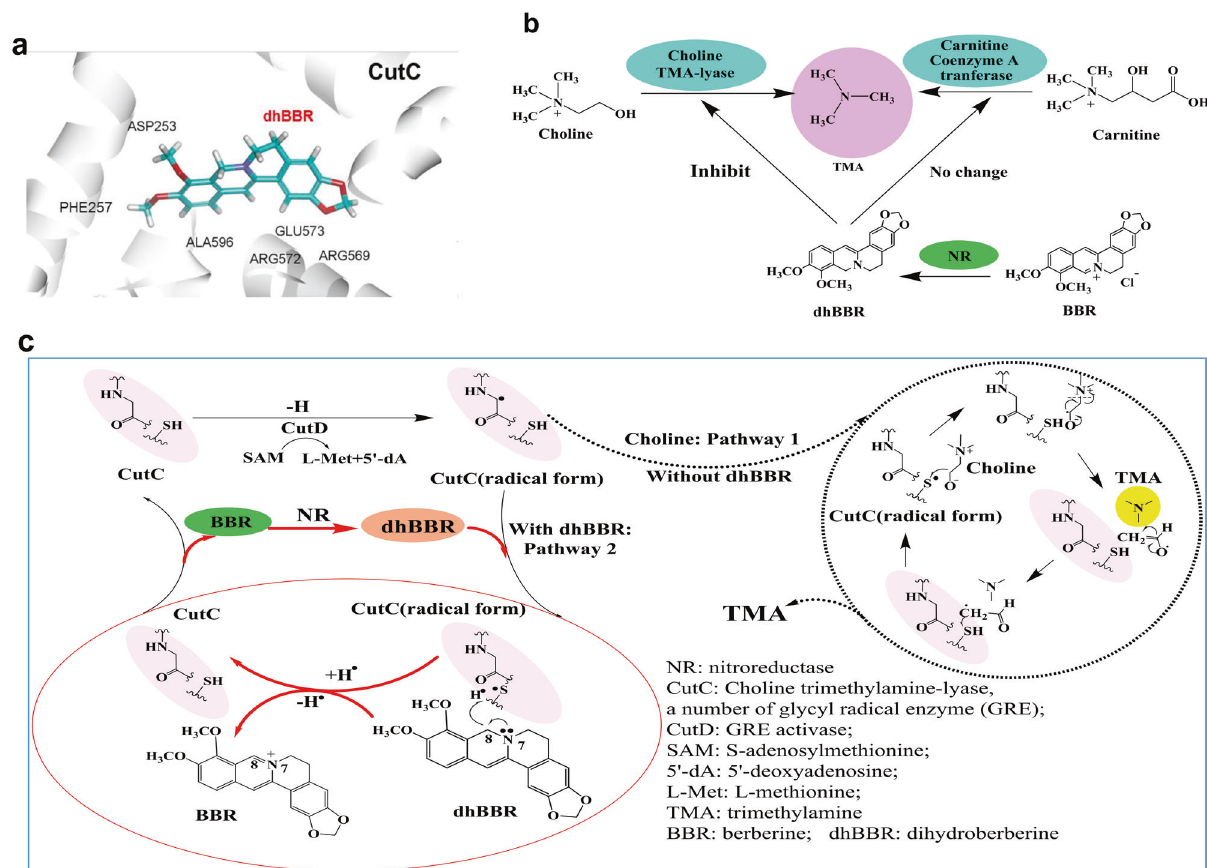
Fig. 2 Putative mechanisms of dhBBR on inhibiting bacterial choline-TMA lyase (CutC). a The 3D docking results of dhBBR and bacterial CutC by CDOCKER tool showed that multiple interactions might mediate the binding of dhBBR into the pocket. b BBR inhibited TMA production through its characteristic metabolite dhBBR from gut microbiota, and the inhibition was on CutC rather than CCAT. c Assumed mechanism of dhBBR in down-regulating